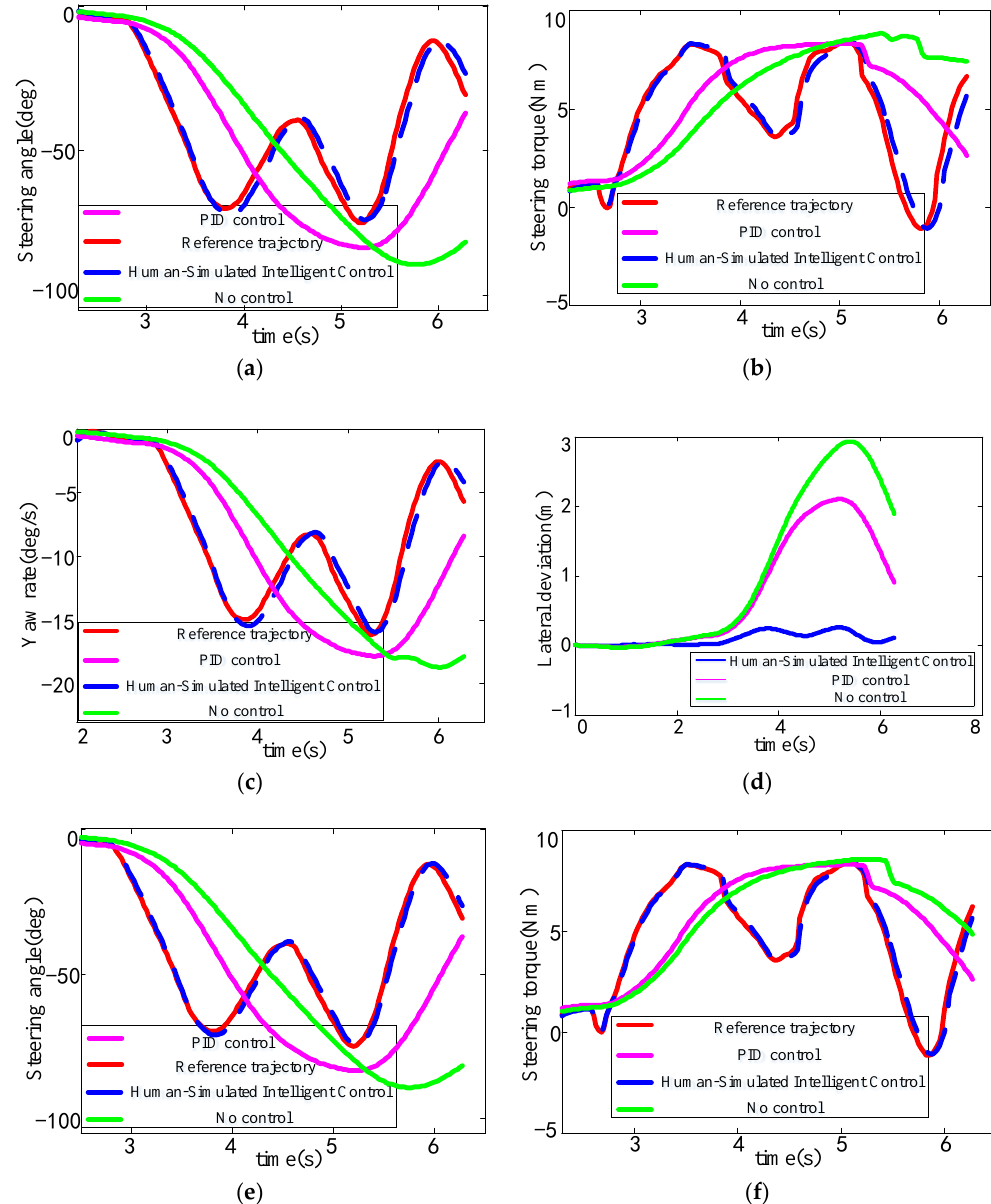
Figure 8. Comparison and analysis of control results under normal right-steering condition: ( a ) 20 km/h, comparison of steering wheel angle; ( b ) 20 km/h, comparison of steering wheel torque; ( c ) 20 km/h, comparison of yaw rate; ( d ) 20 km/h, comparison of lateral deviation; ( e ) 50 km/h, comparison of steering wheel angle; ( f ) 50 km/h, comparison of steering wheel torque.